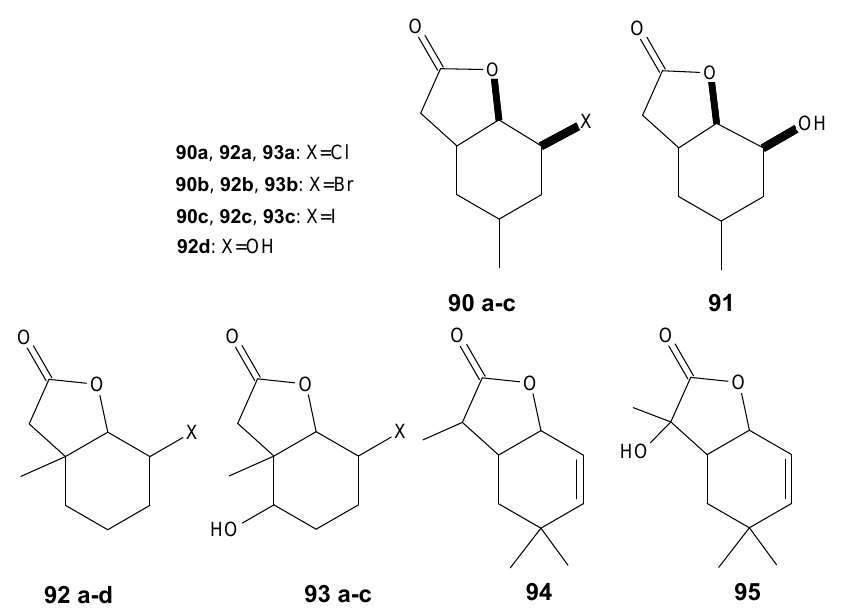
Figure 13. Lactones 90a – 95 .